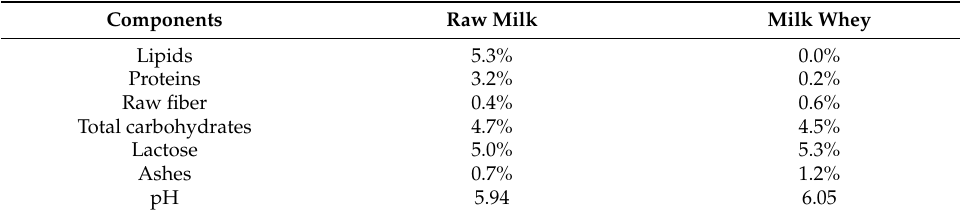
Table 3. Proximate analysis of raw milk and whey obtained with the Carrez method.